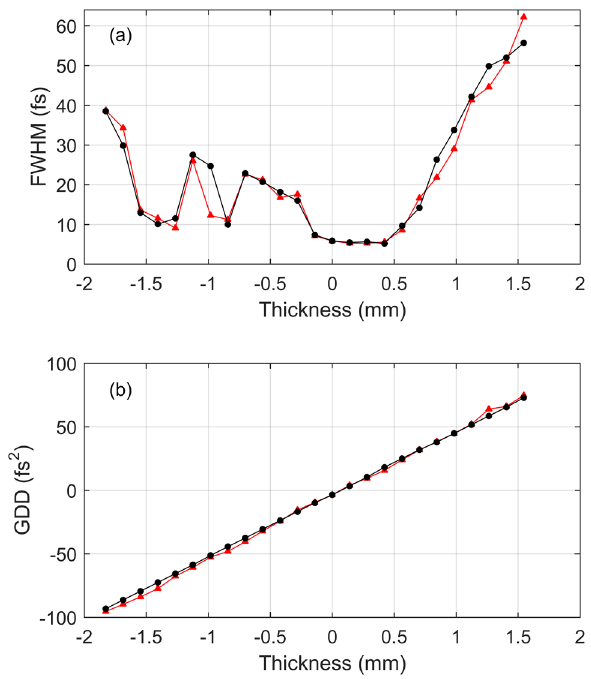
Figure 6. Consistency test of reconstruction of the chirped laser pulses. The laser pulses were measured at different dispersion conditions. The amount of dispersion was controlled by a BK7 glass wedge. ( a ) The reconstructed pulse durations of the chirped laser pulses obtained in experiments (red triangles) and the pulse durations of artificially chirped pulses. The artificially chirped pulses were calculated by adding a theoretical dispersion on the reconstructed laser pulse obtained at the minimum GDD condition. ( b ) The reconstructed GDD of the chirped laser pulses (red triangles) and the GDD of the artificially chirped pulse (black